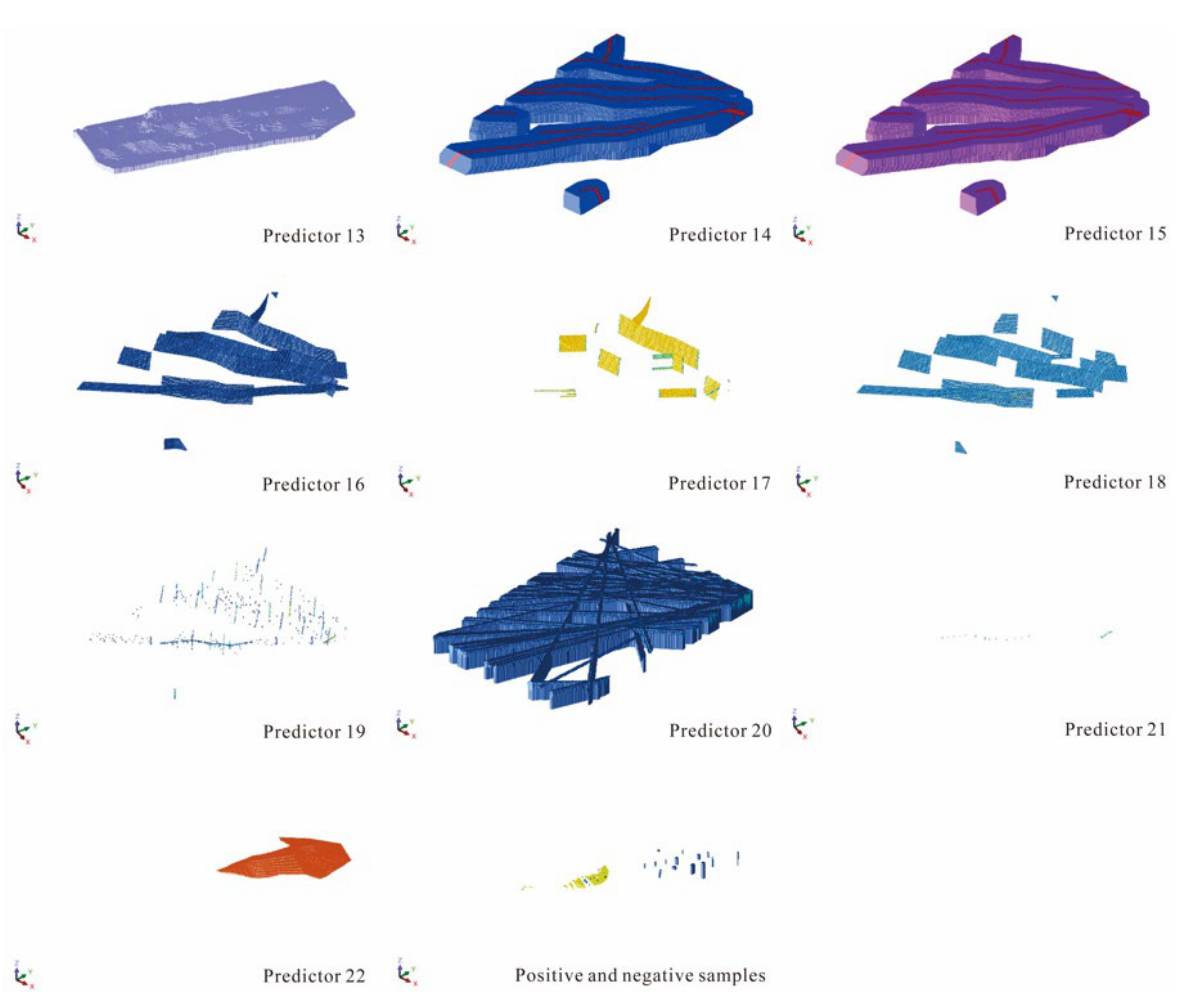
Figure 5. Construction of the 3D pre-training layer in the pre-training area (Area C). According to the 3D weight of the evidence method, the evidence weight of each factor in the study area is shown in Table 7, which intuitively reflects the relationship between various factors and mineralization. Table 7. The evidence weight of Minle manganese mine variables.